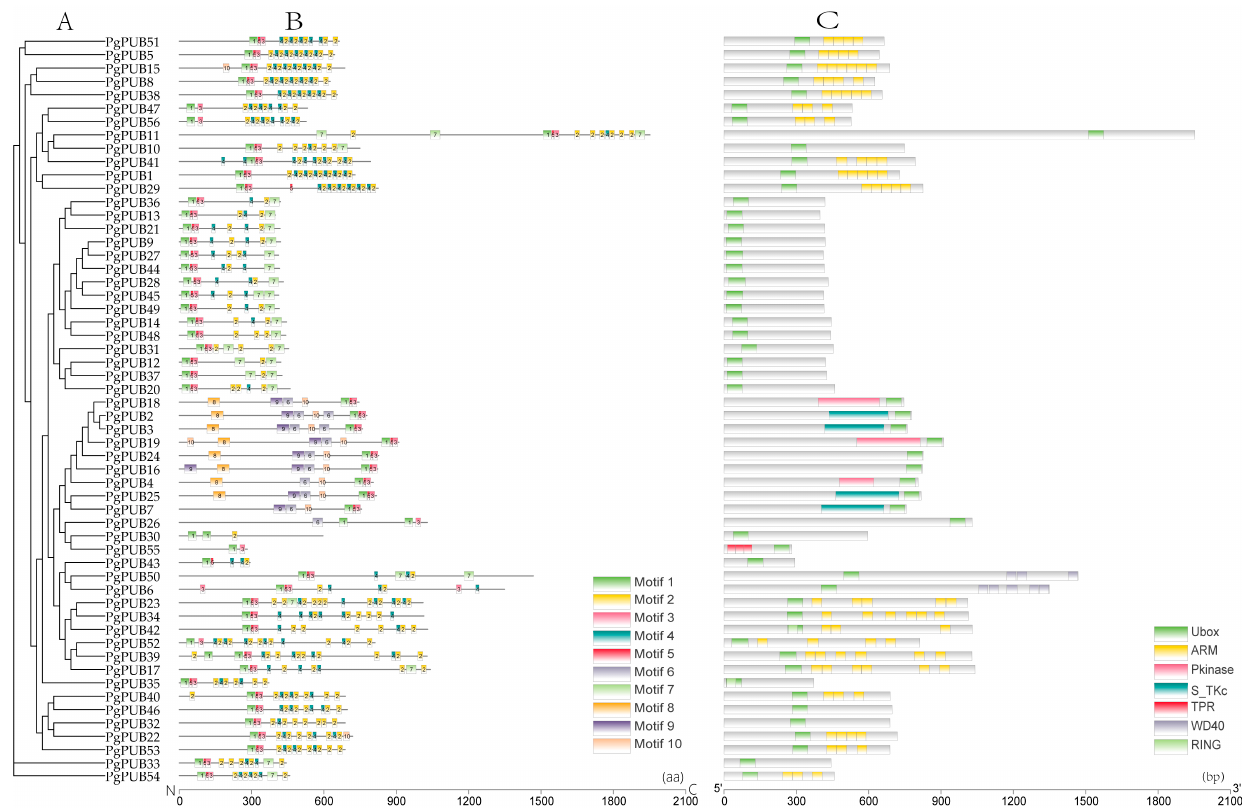
Figure 2. An analytical view of the pomegranate U-box gene family. ( A ) Phylogenetic tree of the 56 PgPUB family members. ( B ) The conserved motifs in the PgPUB proteins; different colored boxes indicates different motifs. ( C ) Schematic representation of domain structures; different colored boxes indicates different domains.